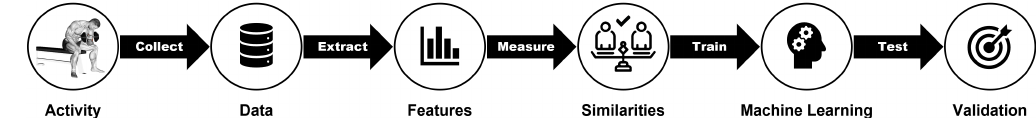
Figure 1. Overview of the similarity-based personalization approach for